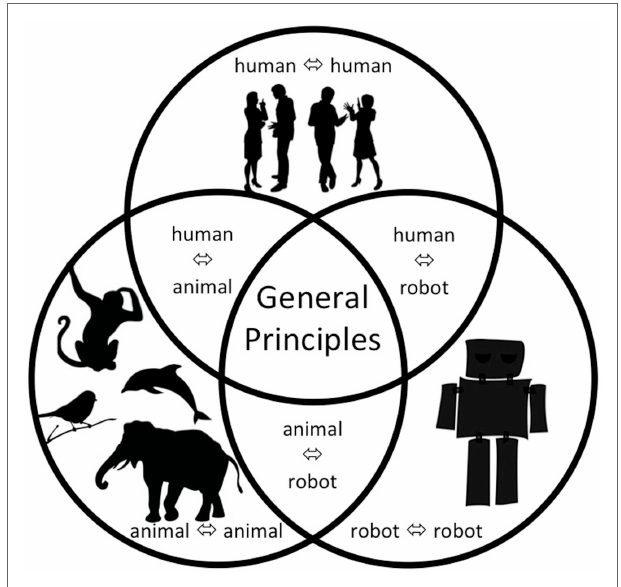
FiGURe 1 | illustration of the key types of vocal interactivity linking humans, animals, and artificial agents (such as robots) .